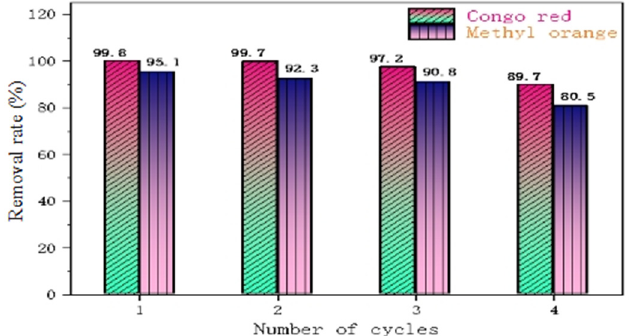
Figure 12. Removal performance of PLLA/CS–GO/TiO 2 towards MO and CR over four cycles.